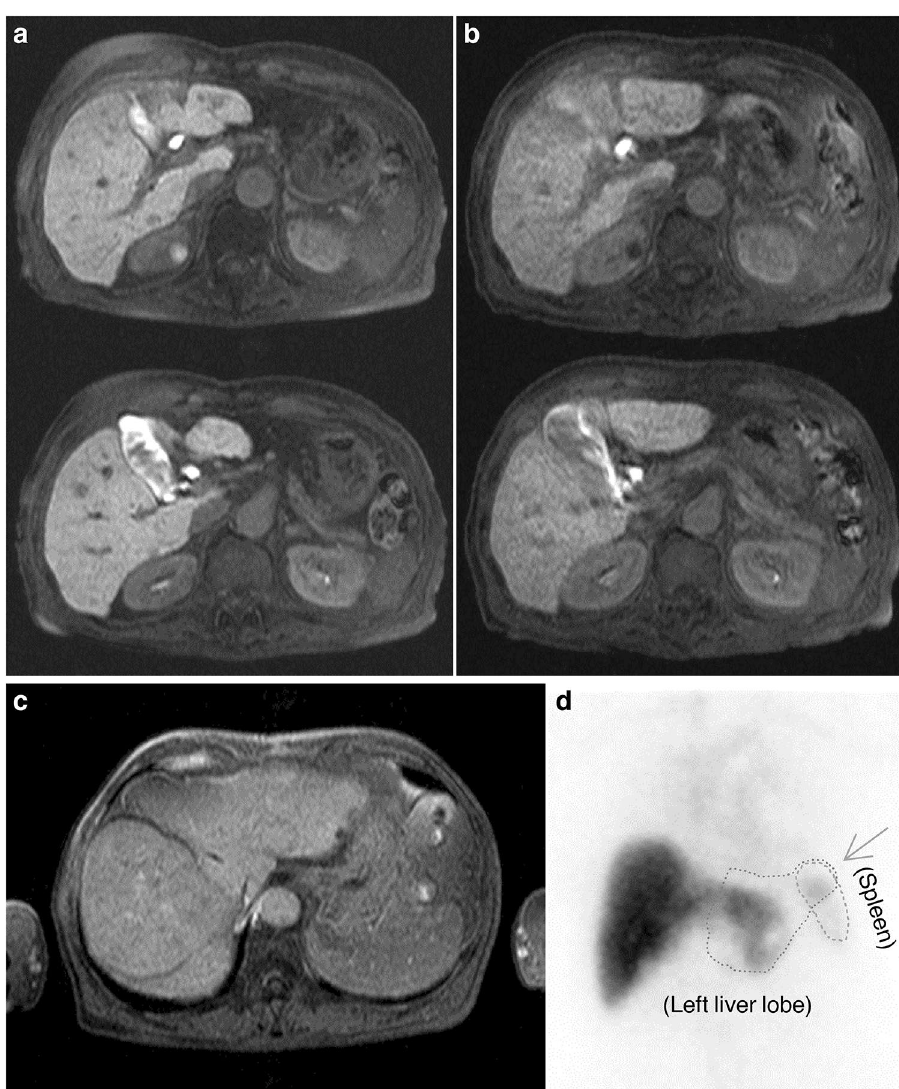
Figure 2. Example of image deterioration. ( a ) Images without motion artifacts (LSC = 0.294). ( b ) Images with motion artifacts (LSC = 0.125). By poor breath holding, the LSC decreases, and the white streak from a gall bladder arises for the respiratory motion artifacts. ( c ) Image of inhomogeneous fat supression. The fat supression do not work around a right anterior segment. ( d ) Image overlapping with the blood pool. The left lobe of the liver overlaps with a part of the spleen (leftward